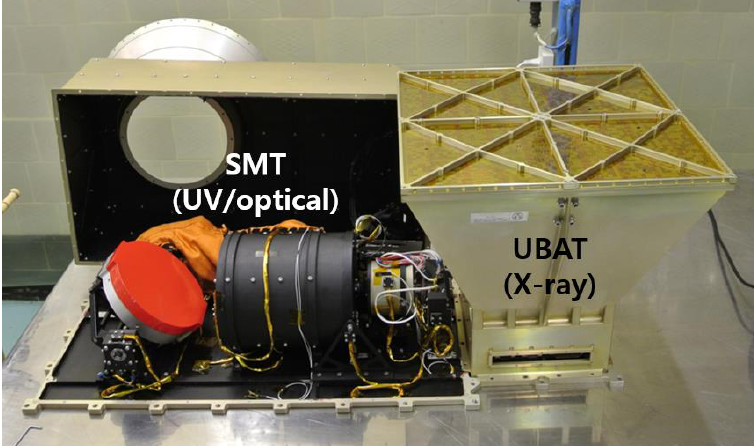
Figure 1. The UFFO/ Lomonosov flight model. It consists of an SMT and a UBAT. The housing, slewing mirror (red cap), telescope (black cylinder), and electronics of the SMT are shown.